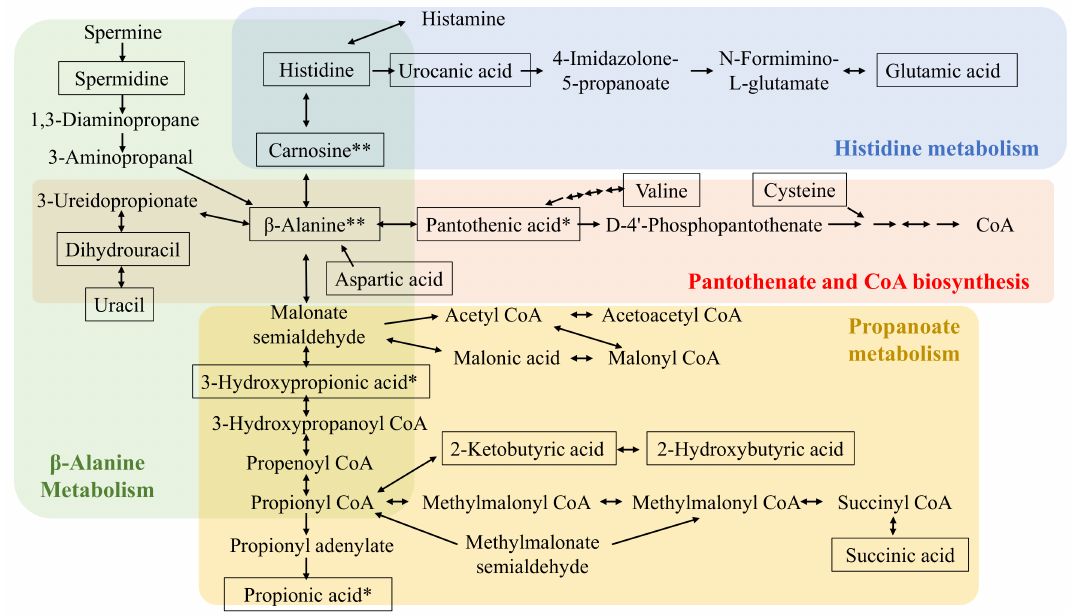
Figure 1. Carnosine-related metabolism. Boxed metabolites are quantified or semi-quantified metabolites in the liver, gastrocnemius muscle, or cecal content. * indicates metabolites a ff ected by meat species in cecal content. ** indicates metabolites a ff ected by meat species in both cecal content and liver. CoA, coenzyme